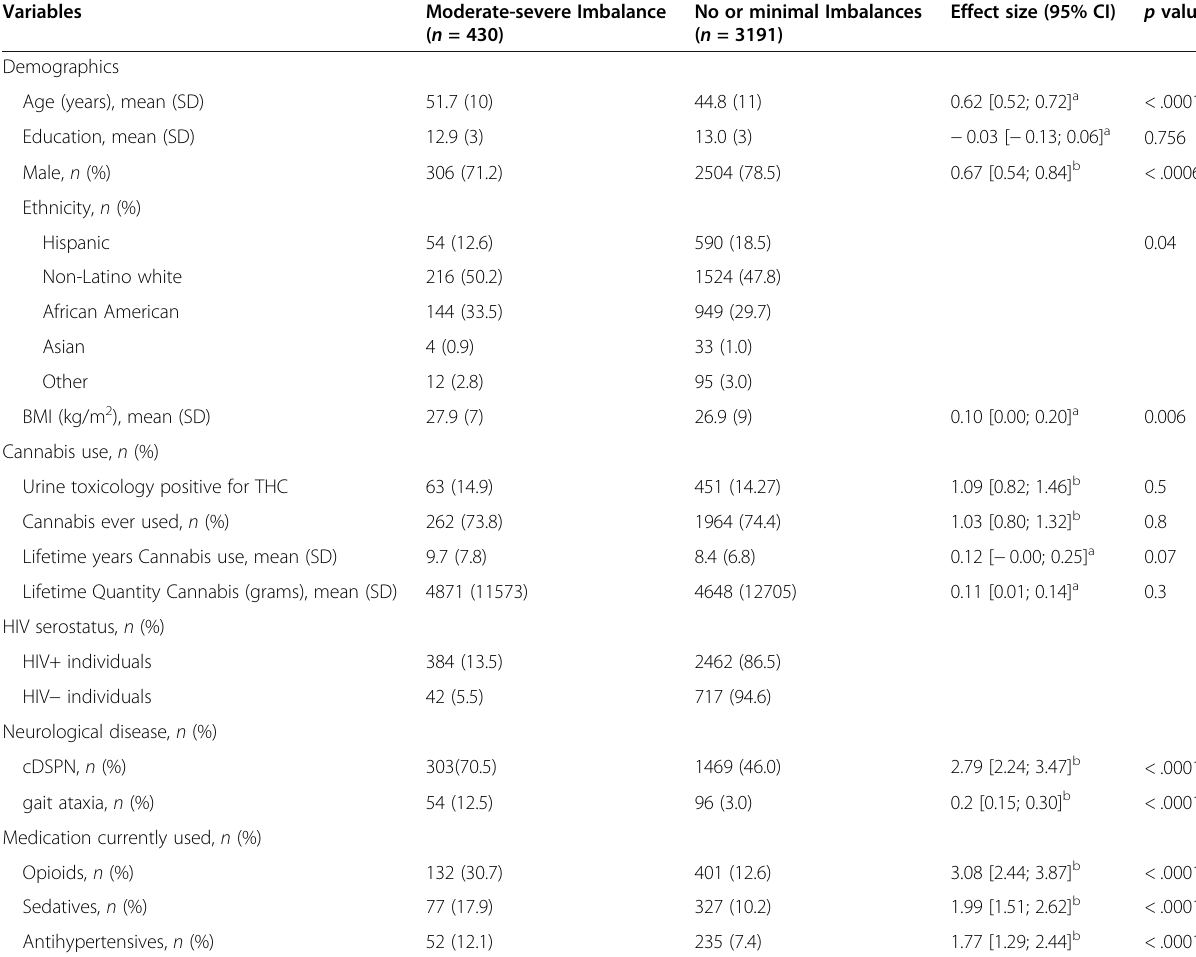
Table 2 Participant characteristics stratified by severity of balance disturbance Variables